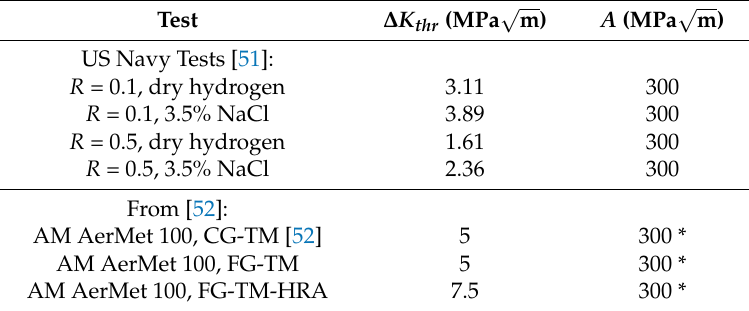
Figure 11. Plot of (cid:1856)(cid:1853)/(cid:1856)(cid:1840) versus (cid:2940)(cid:3012) (cid:2879) (cid:2940)(cid:3012) (cid:3295)(cid:3283)(cid:3293) Figure 11. Plot of da / dN versus Table 7. Values of ∆ K thr and A used in Figures 11 and Table 7. Values of ∆(cid:1837) (cid:3047)(cid:3035)(cid:3045) and (cid:1827) used in Figures 11 and 12.